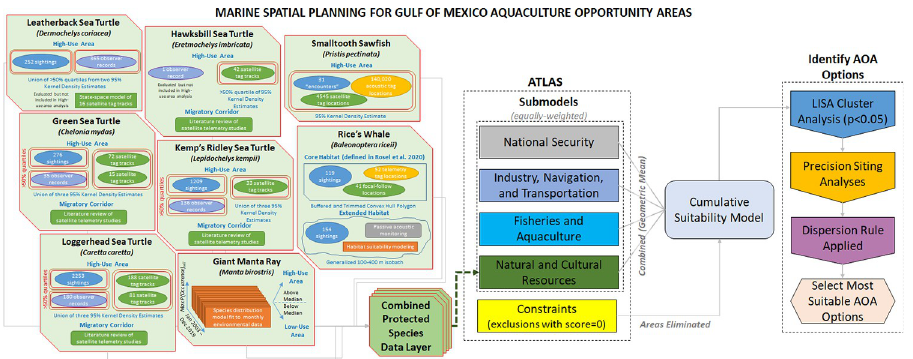
Fig 2. Gulf of Mexico aquaculture marine spatial planning process. Flow chart illustrating how protected species data layers were generated from underlying data and integration of the combined protected species data layer (red outlines) into the broader Aquaculture Opportunity Area (AOA) Atlas marine spatial planning process used to identify final AOA options, as further described in [13].